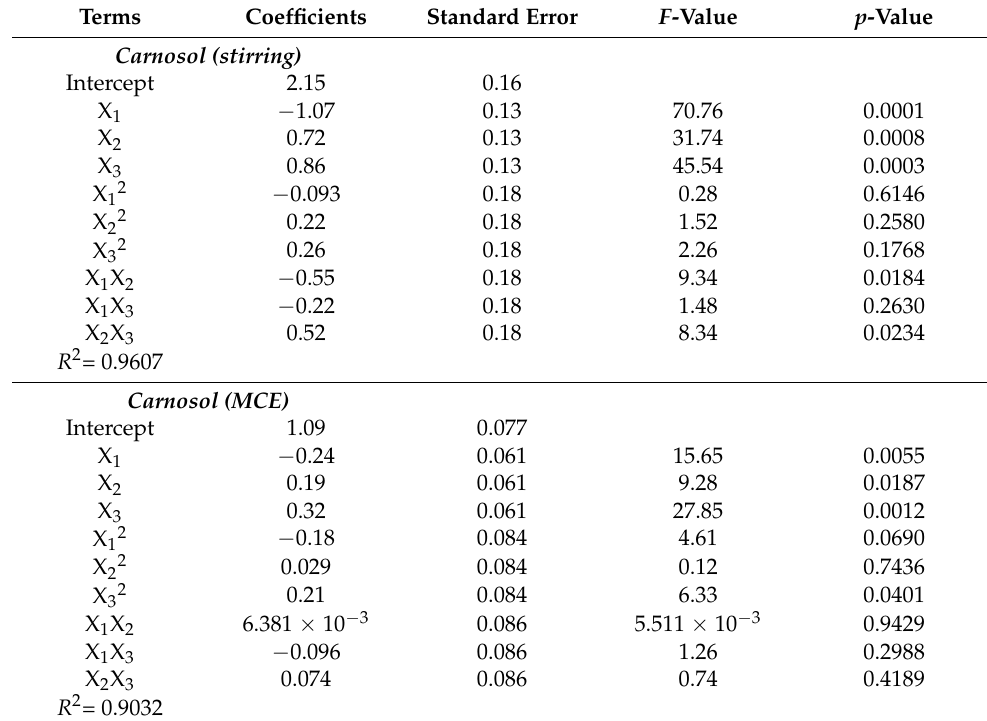
Table A2. Regression coefficient of polynomial function of all response surfaces for carnosol.